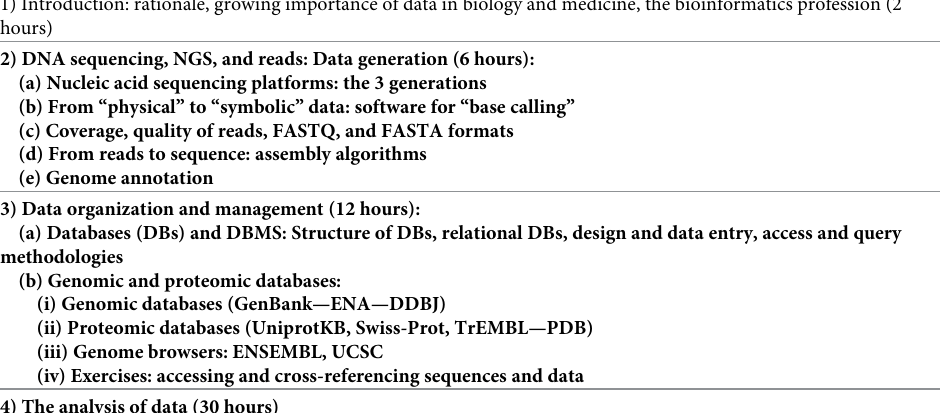
Table 3. Recommended contents for bioinformatics courses embedded in a study path belonging to an MSc degree in the life science and medicine scientific area. 1) Introduction: rationale, growing importance of data in biology and medicine, the bioinformatics profession (2